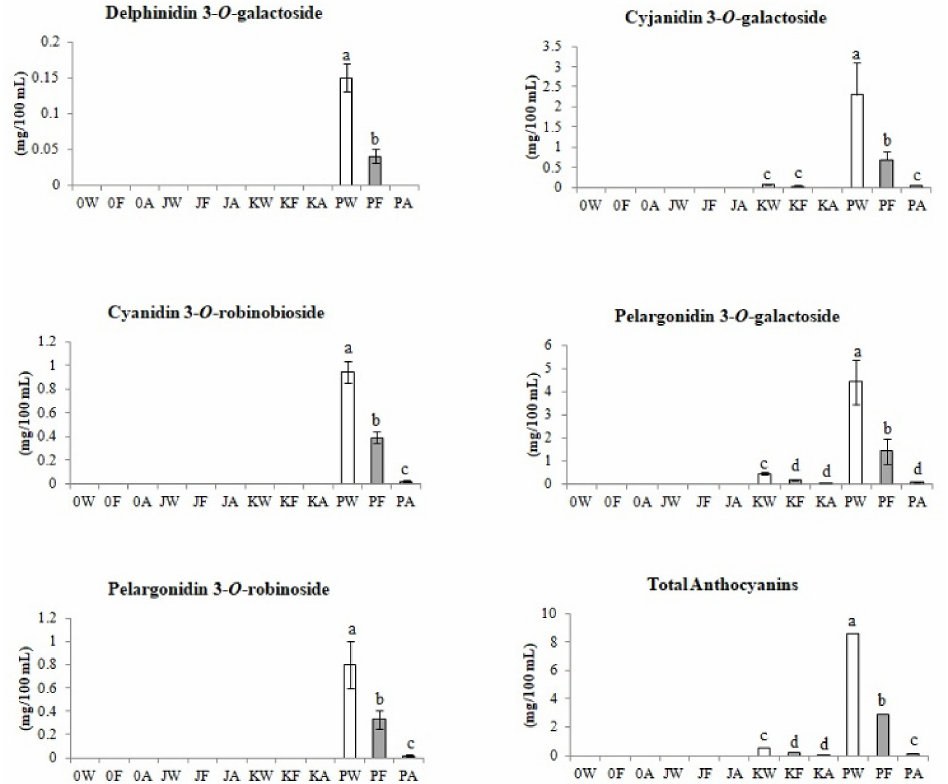
Figure 4. Changes in anthocyanins content (mg/100 mL) during control and fruit meads production technology. White bars—worts (W), light gray bars—samples after fermentation (F), dark gray bars— meads after aging (A). Sample codes: 0—control, J—samples with ‘Jantarnyi’ juice, K—samples with ‘Koralowyi’ juice, P—samples with ‘Podolski’ juice. Mean values with different letters: a, b, c, d are statistically different ( p <